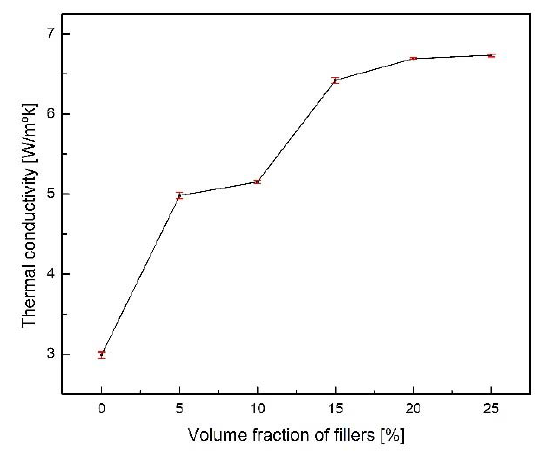
Figure 7. Thermal conductivity of thermal grease of volume fraction of copper powder.